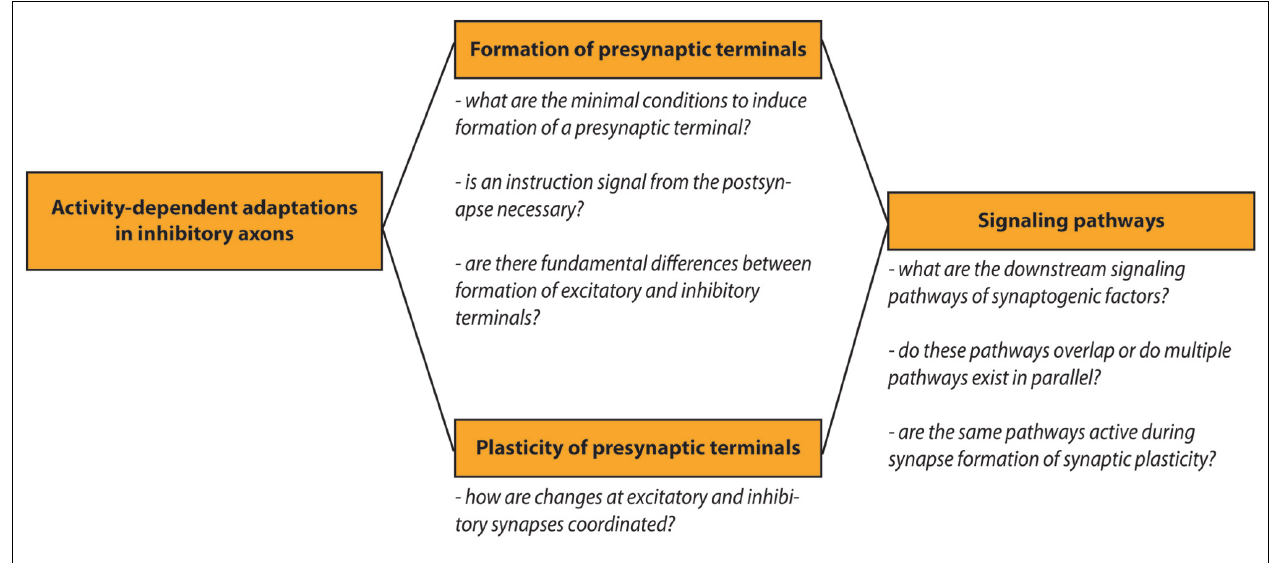
FIGURE 3 | Outstanding research questions. Schematic overview of open research questions on activity-dependent adaptations in inhibitory axons.